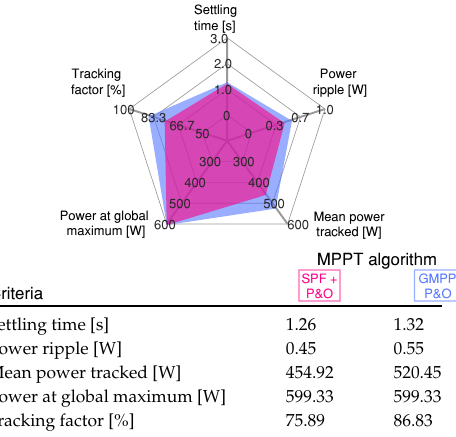
Figure 6. Comparative analysis of the MPPT methods for Scenario 1 shown in Figure 5.